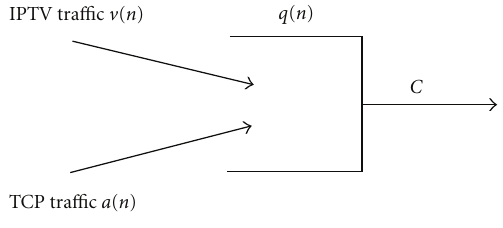
Figure 1: The queueing model.